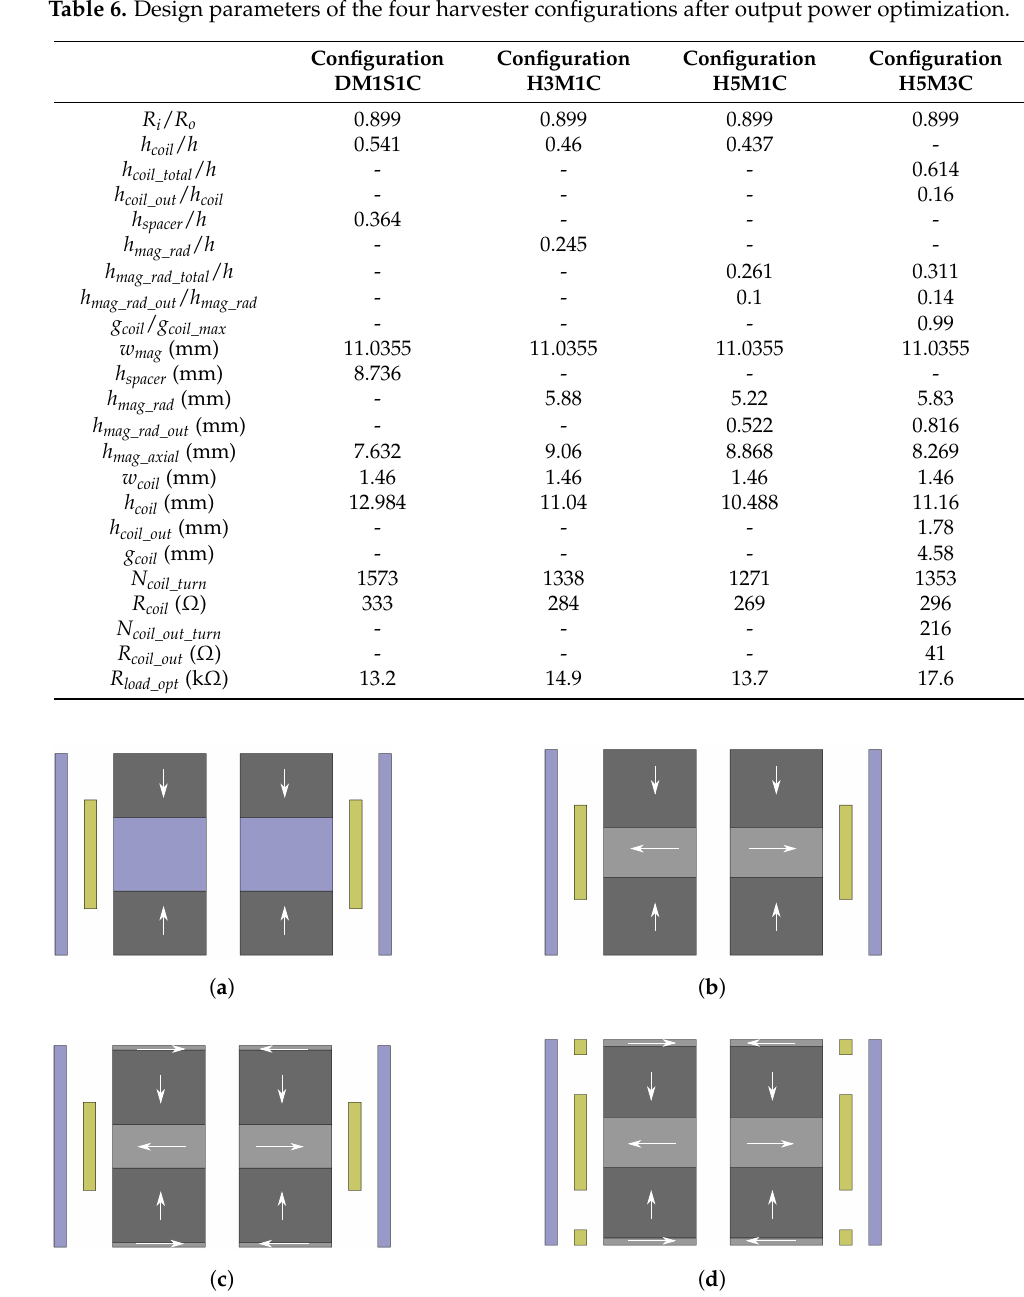
Figure 10. Resulting structures of the four configurations after output power optimization: ( a ) Con- figuration DM1S1C. ( b ) Configuration H31C. ( c ) Configuration H5M1C. ( d ) Configuration H5M3C.